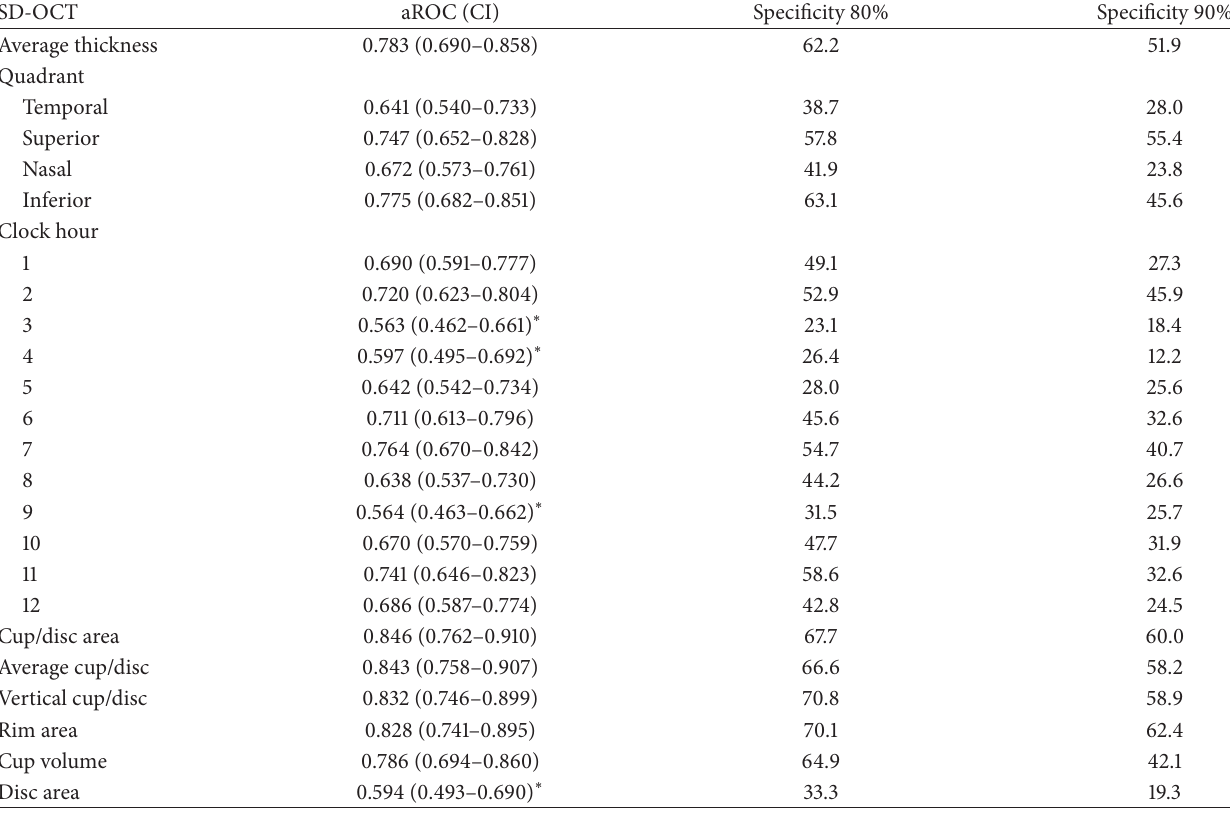
Table 3: Areas under the ROC curve (aROCs) for each SD-OCT parameter and sensitivities (%) with fixed specificities of 80% and 90%.